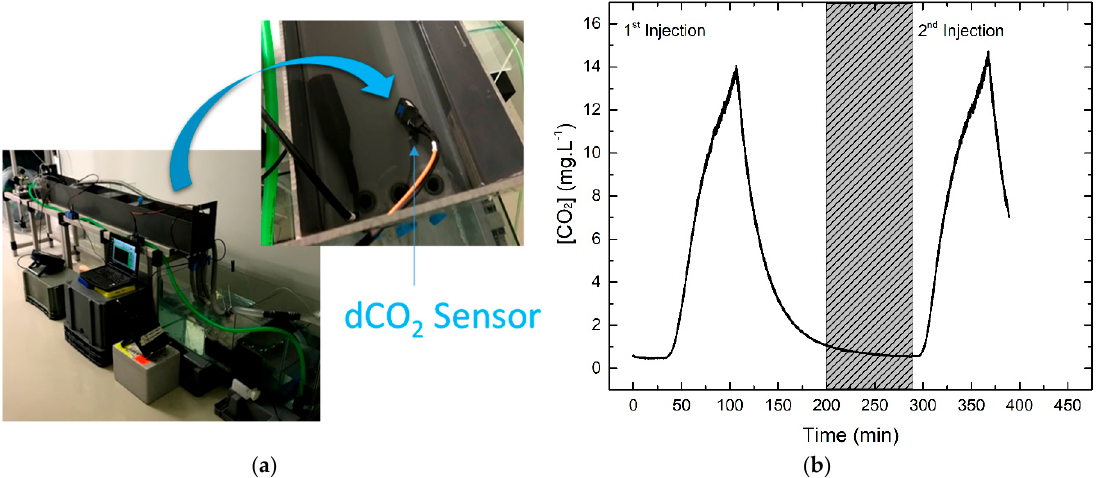
Figure 3. ( a ) Laboratory set-up of a Recirculating Aquaculture System using freshwater and ( b ) registered data obtained from 1 h of CO2 injection (7.5 mL·min − 1